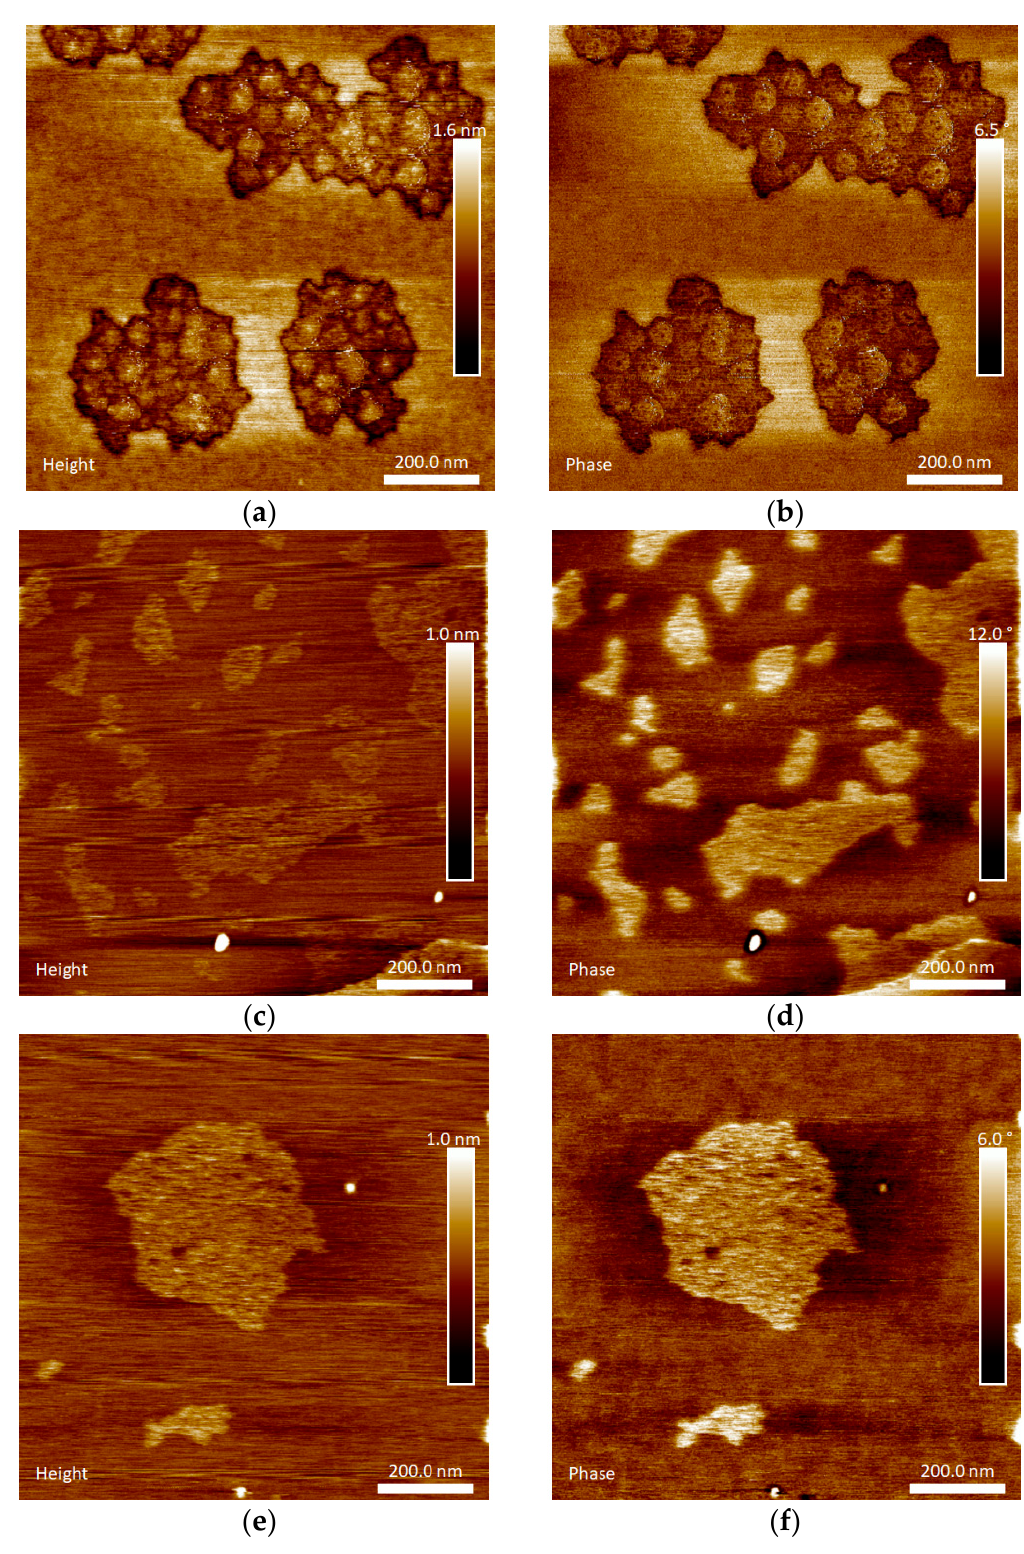
Figure 3. AFM topographic images of ( a , b ) α -MnO 2 nanoparticles; ( c , d ) commercial activated carbon Hydrodarco ® 3000; ( e , f ) synthesised MnO 2 /GAC-3 composite.